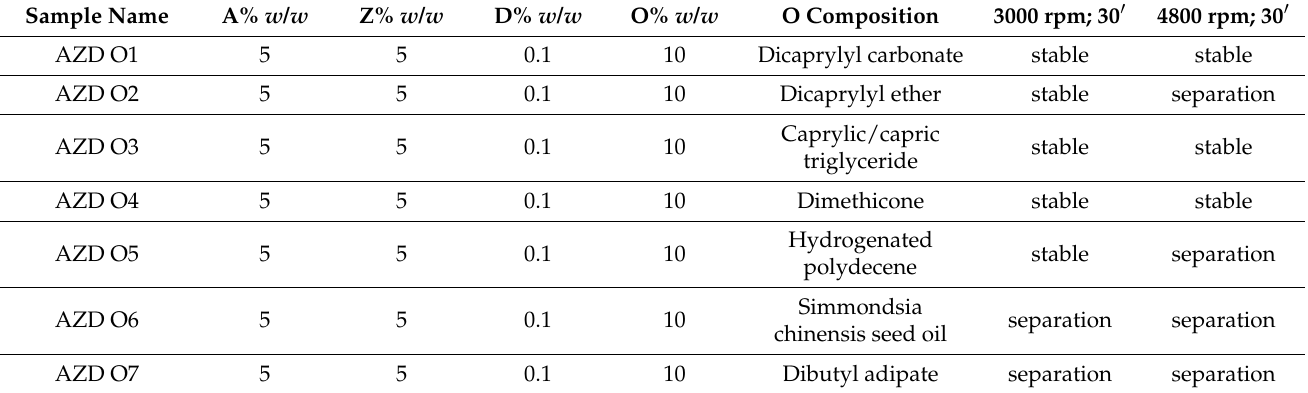
Table 6. Stability test results of emulsions formulated with Zea mays starch A and zinc oxide Z (total